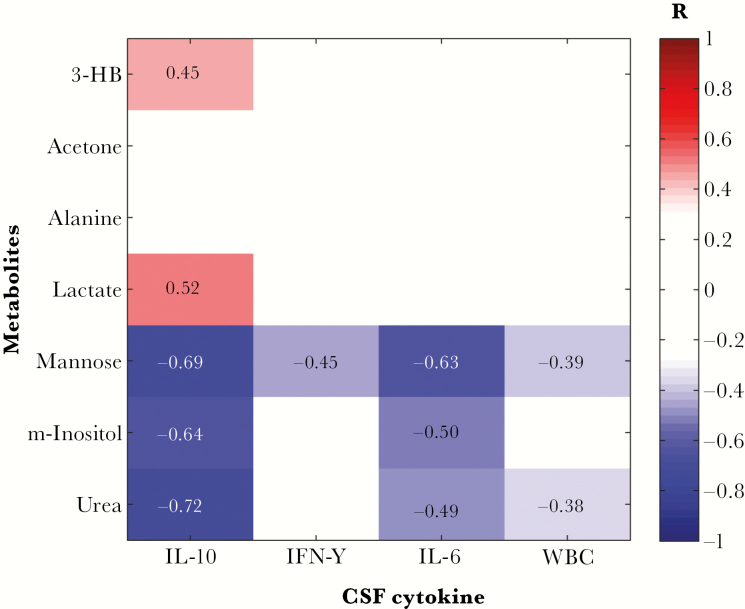
Metabolites discriminatory for patient neurological symptoms correlate with immunological measures in the central nervous system. False discovery rate–corrected Spearman-ranked correlation coefficient matrix shows statistically significant (P < .05) positive and negative correlations. 3-HB, 3-hydroxybutyrate; IL-6, interleukin 6; IL-10, interleukin 10; IFN-γ, interferon-γ; m-inositol, myo-inositol; WBC, white blood cell count.